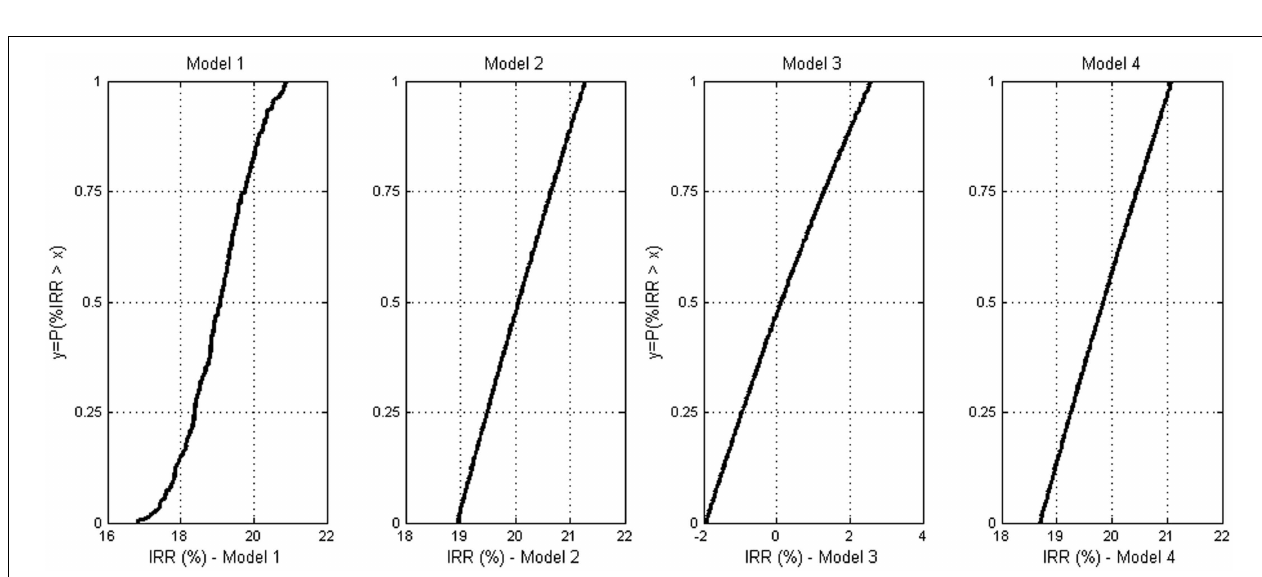
FIGURE 5 | Diethyl ether production: the empirical cumulative distribution function (ECDF) of the IRR estimated from four estimation models .